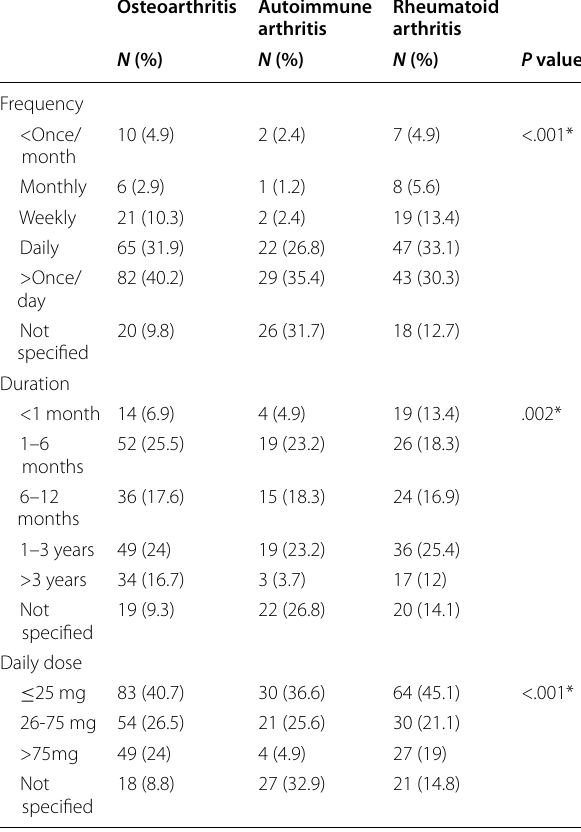
Table 5 Utilization of CBD in 428 patients with arthritis based on type of arthritis